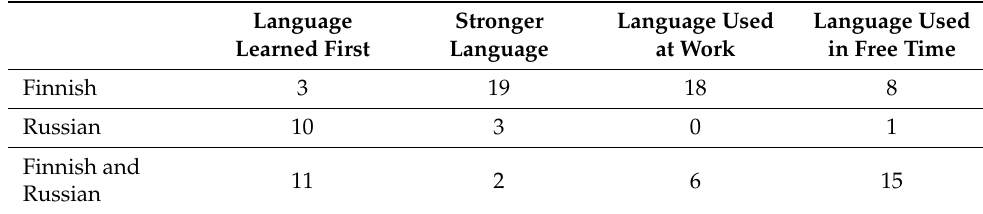
Table A1. Finnish language background of the Russian background participants. Numbers indicate the number of Russian background